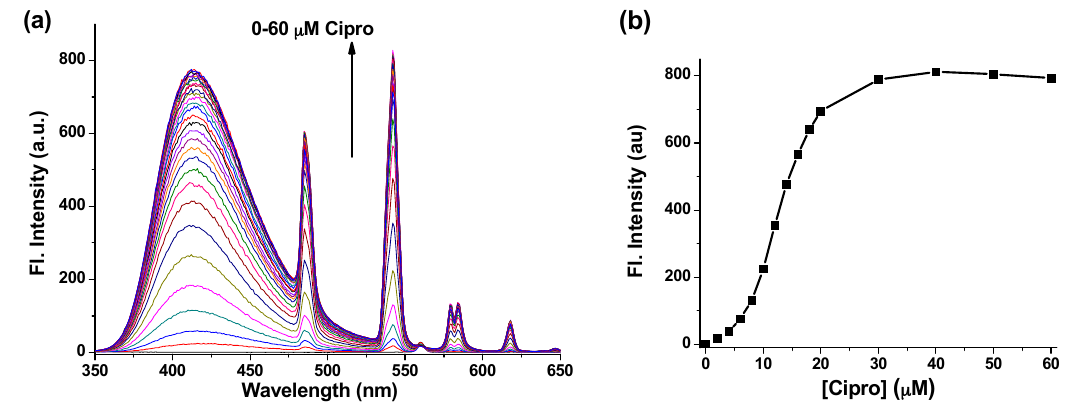
Figure 4. ( a ) Emission changes of Tb-DO3A (10 µM) with the increasing concentrations of Cipro (0–60 µM) in HEPES buffer (pH = 7.4); ( b ) Plot of terbium emission intensity at 542 nm vs. Cipro concentration. The spectra were recorded after excitation at 278 nm.